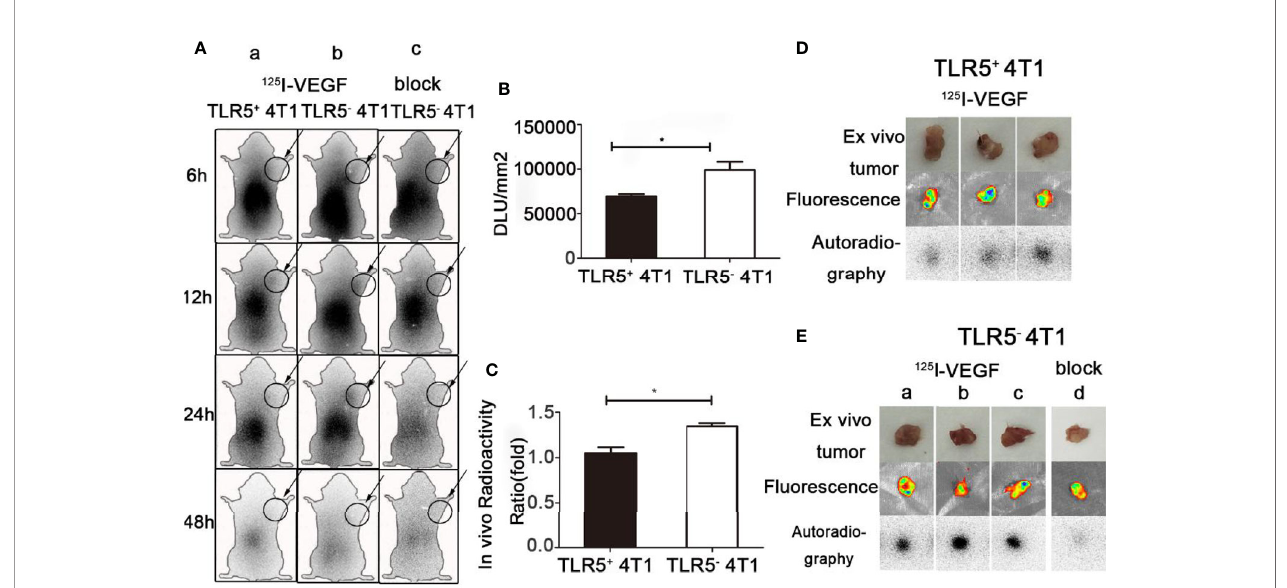
FIGURE 4 | Whole-body phosphor-autoradiography and fl uorescence imaging. Whole body phosphor-autoradiography of 125 I-VEGF in TLR5 + 4T1 tumor bearing mice (A a ) and TLR5 − 4T1 tumor bearing mice (A b ) at 6, 12, 24, and 48 h post-injection, and whole-body phosphor-autoradiography images of 125 I-VEGF in TLR5 - 4T1 tumor bearing mice with inhibitor blocked group (A c ) at 6, 12, 24, and 48 h post-injection. DLU/mm 2 measurements in TLR5 + and TLR5 ‐ 4T1 tumors (B) . Comparison of in vivo radioactivity ratio (the ratio of DLU/mm2 from tumor and opposite muscle of TLR5 + / − 4T1 tumors in whole-body phosphor-autoradiography at 24 h (C) . Phosphor-autoradiography and fl uorescence of isolated tumors from TLR5 + 4T1 tumor bearing mice (D) . Phosphor-autoradiography and fl uorescence of isolated tumors from TLR5 − 4T1 tumor mice injected with 125 I-VEGF (E a – c ) and with inhibitor blocked (E d ) . The data were presented from three independent experiments and analyzed by Student ’ s t test. *P <